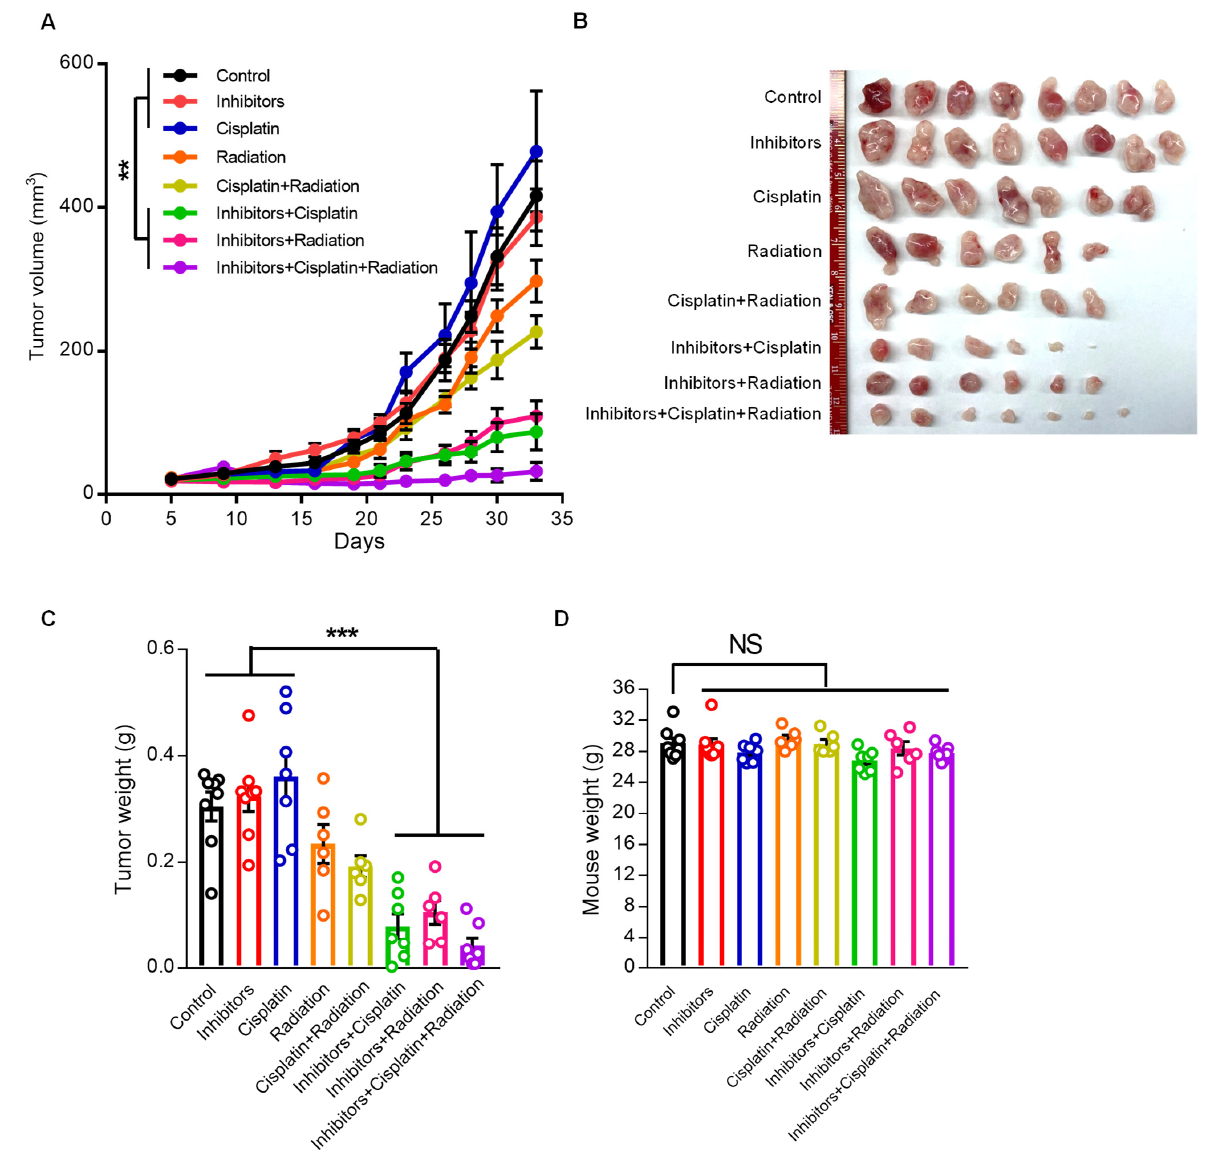
Figure 7. The effect of miR124-3p and miR766-3p inhibition on resistant HNSCC progression. ( A – D ) Anti-cancer effect of cisplatin (2.5 mg/kg/mouse, i.p., every three days), miRNA inhibitors (1 μ g/tumor, every three days, intratumor injection), or radiation (8 Gy/tumor, Day 7) as monotherapy and multimodality therapy regimens on xenograft mouse model bearing CAL27/FP-R resistant tu- mors. CAL27/FP-R cells were implanted into the subcutaneous tissue of the right abdominal wall of male nude mice. After tumor was established, mice were sorted into eight groups and treated with either cisplatin or miRNA inhibitors or radiation alone or in combination as cisplatin+radiation or miRNA inhibitors+cisplatin or miRNA inhibitors+radiaition or miRNA inhibitors+cisplatin+radiai- tion. The plot depicting comparison of tumor growth rates ( A ). The representative images ( B ) and weights ( C ) of CAL27/FP-R tumors are shown. ( D ) Showing mice weights at day 33. A one-way ANOVA with Bonferroni’s correction for multiple comparisons was used to analyze group compar- isons, and data are presented as means ± SEM (n = 6–8 per group). ** p < 0.01 and *** p < 0.001.